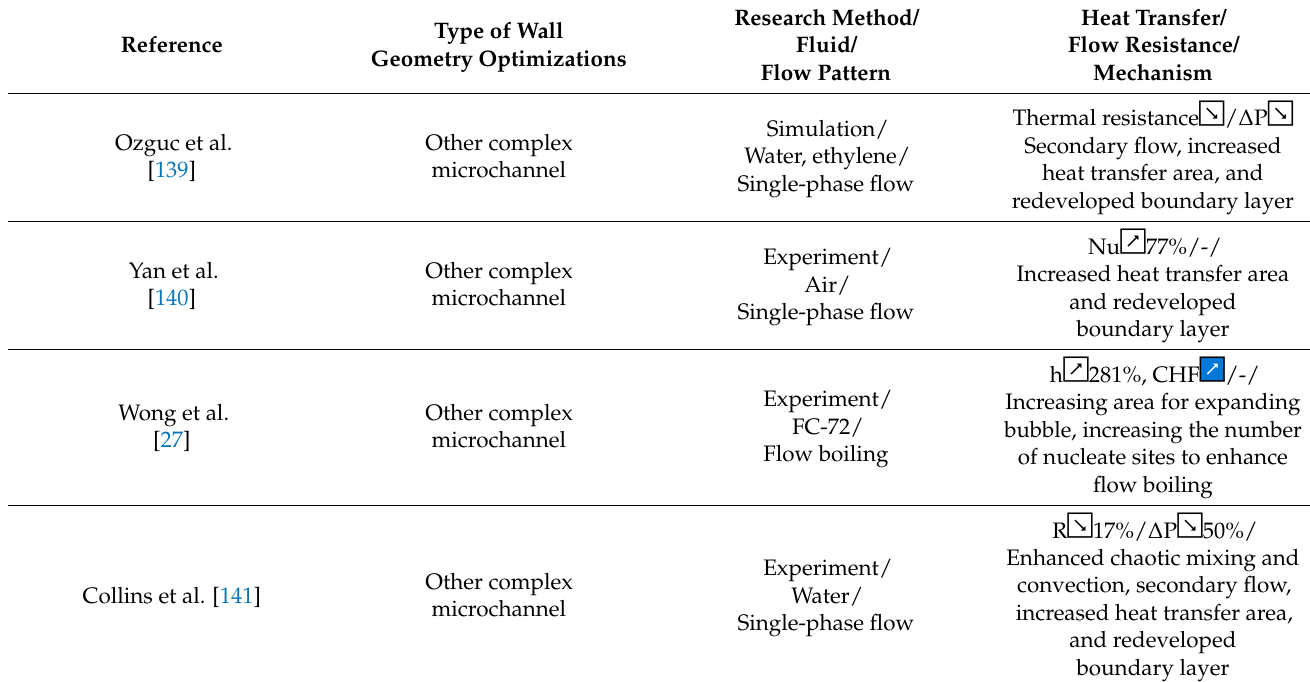
Figure 22. Schematic diagram of complex manifold hybrid microchannel: ( a ) Ozguc et al. (adapted from Ref. [139]), ( b ) Yan et al. (adapted from Ref. [140]), ( c ) Wong et al. (adapted from Ref. [27]), ( d ) Collins et al. (adapted from Ref. [141]). Table 6. Selected studies of geometric optimization on complex geometry microchannel on heat transfer. Table 6. Cont.